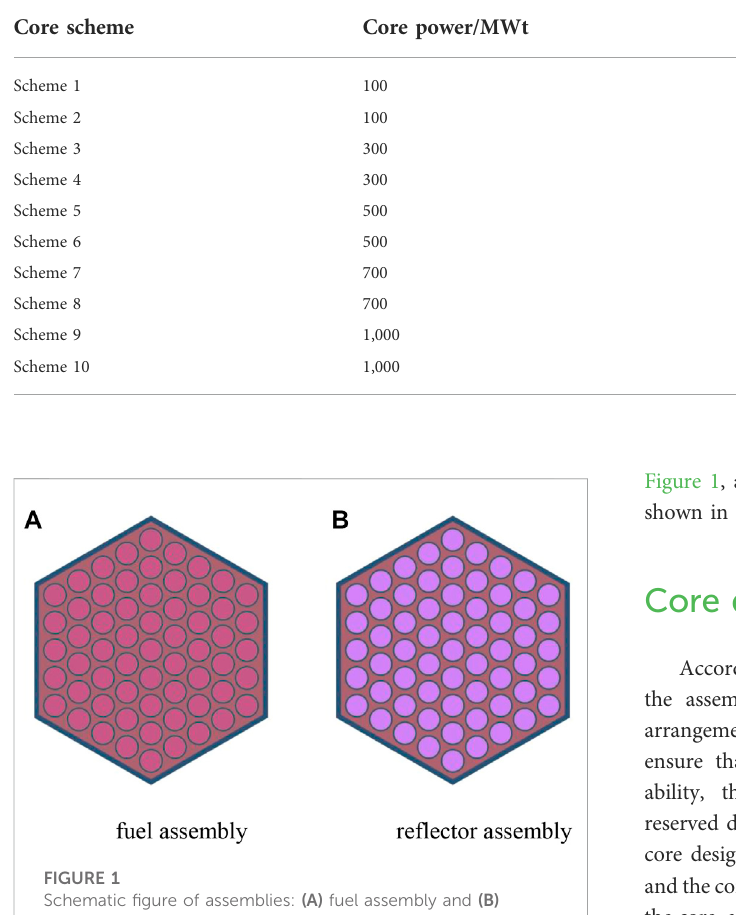
TABLE 1 Main design parameters of 10 schemes.